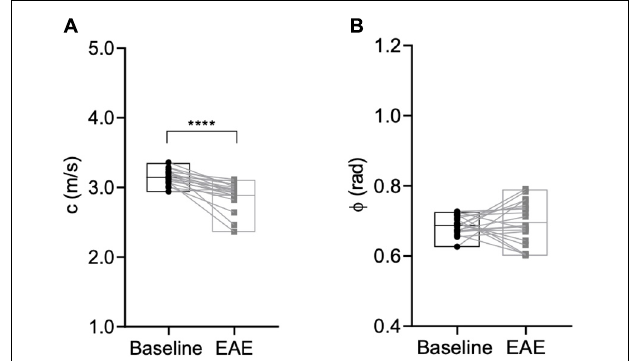
FIGURE 4 | Global brain softening due to inflammation. (A) Whole brain stiffness is reduced during inflammation ( p < 0.0001, Wilcoxon matched-pairs signed rank test), whereas (B) fluidity is unaffected ( p = 0.6070, paired t -test). n = 19; mean, min/max. **** p ≤ 0.0001.